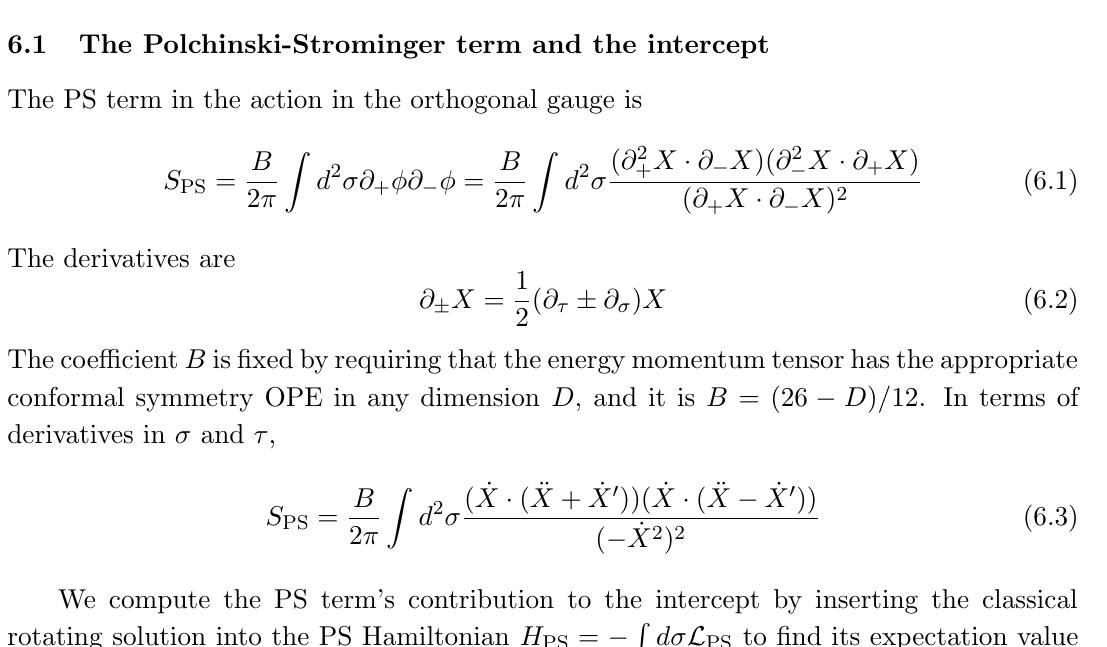
= (cid:13) 2 (cid:12) 2 2 m 24